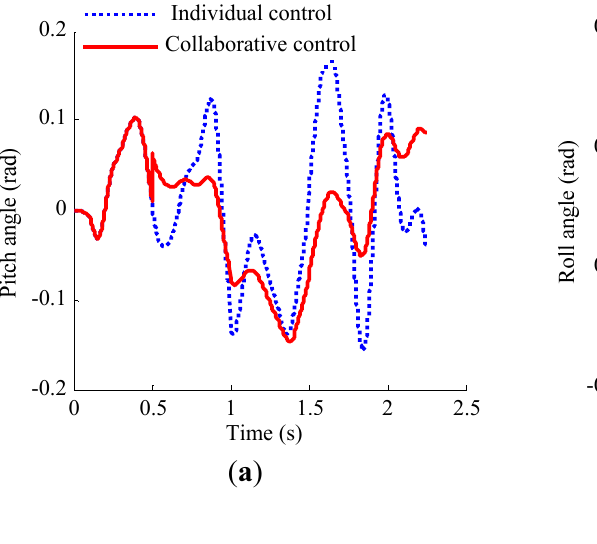
Figure 5. Simulation results of vehicle pitch and roll angle: ( a ) Pitch angle; ( b ) Roll